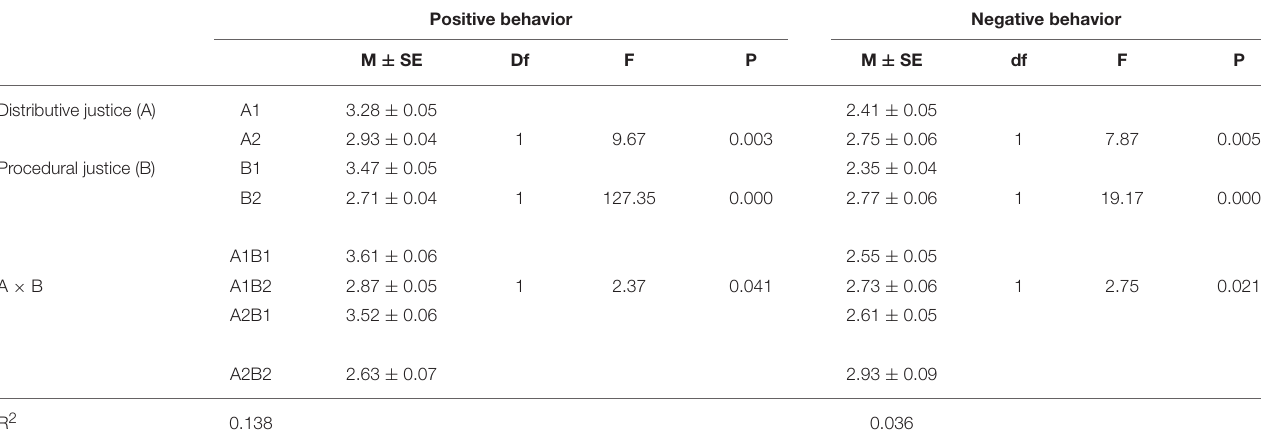
TABLE 7 | Effects of distributive justice and procedural justice on positive/negative organizational behavior. Positive